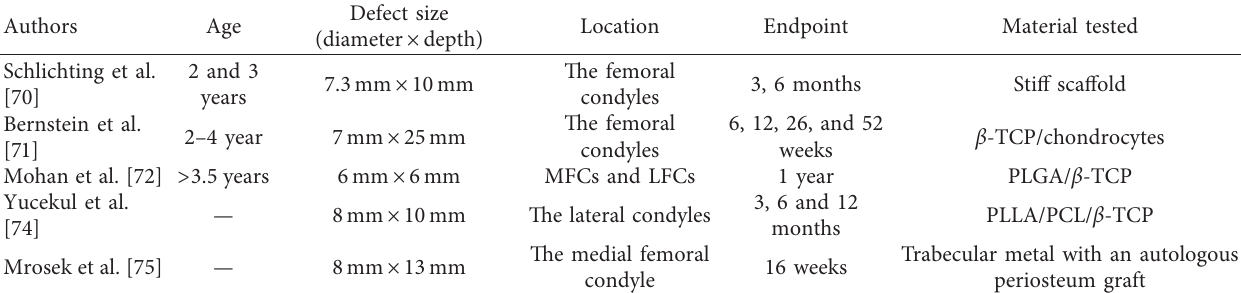
Table 6: Examples of studies using sheep osteochondral defect